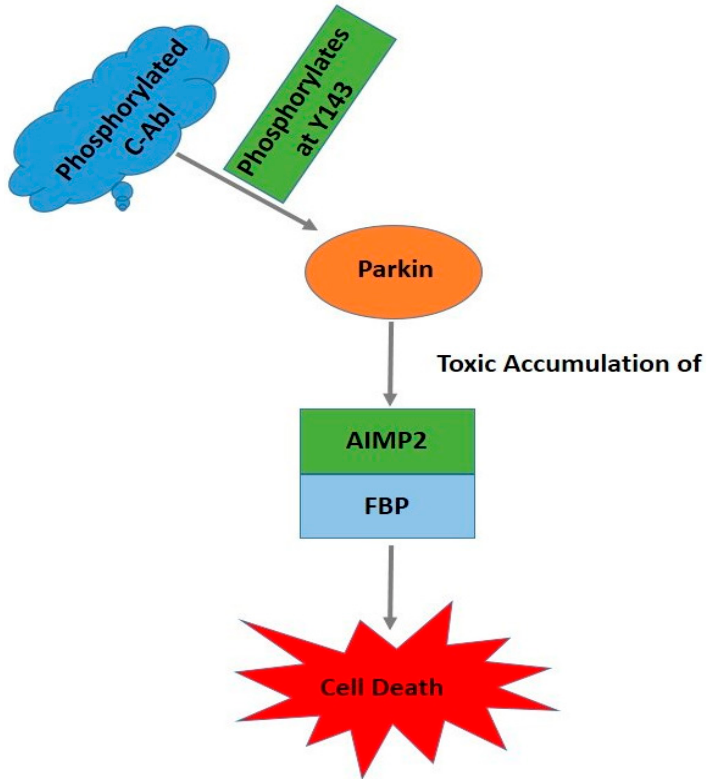
Figure 2. Phosphorylated c-Abl tyrosine phosphorylates parkin at Y143, which leads to the loss of ubiquitin-ligase activity, the accumulation of toxic parkin substrates, and neuronal death. AIMP2: aminoacyl tRNA synthetase complex-interacting multifunctional protein 2; FBP: far up stream element binding protein.